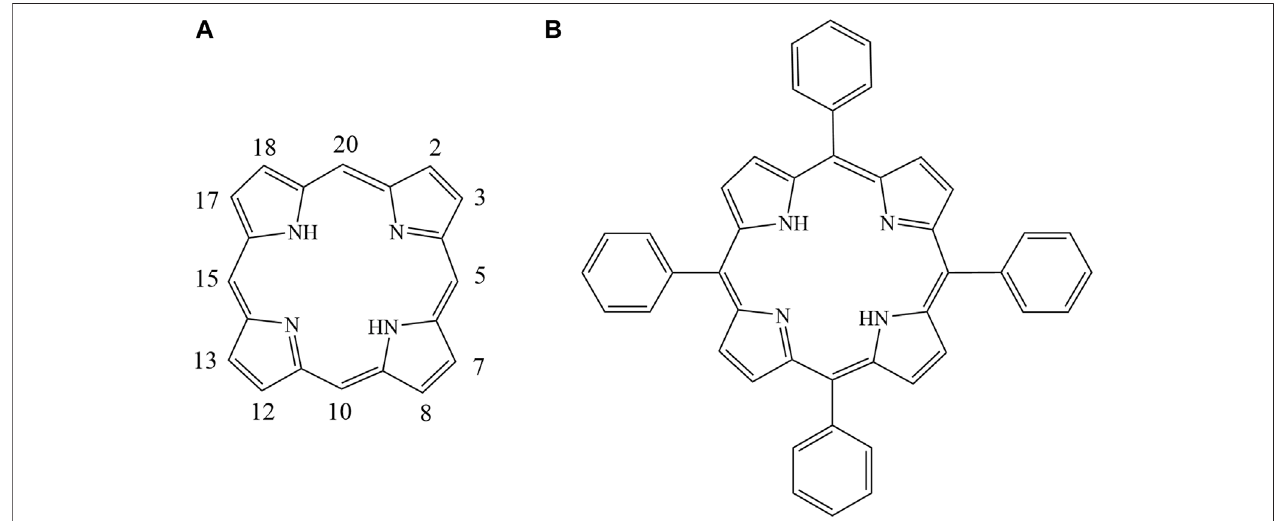
FIGURE 1 | Structures of tetraphenyl porphyrin (A) . 5,10, 15, 20 meso-positions; (B) . 2,3,7,8,12, 13, 17,18 β